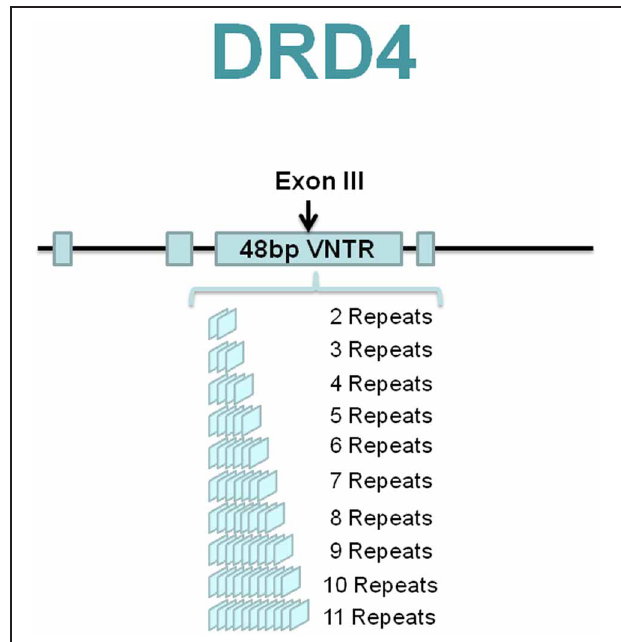
FIGURE 1 | DRD4 exonIII